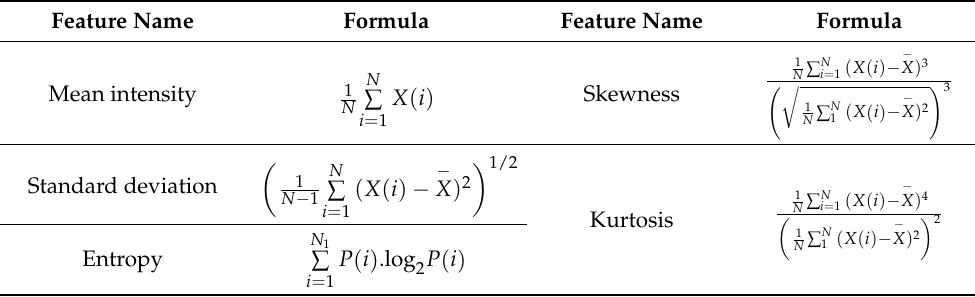
Table 2. Statistical